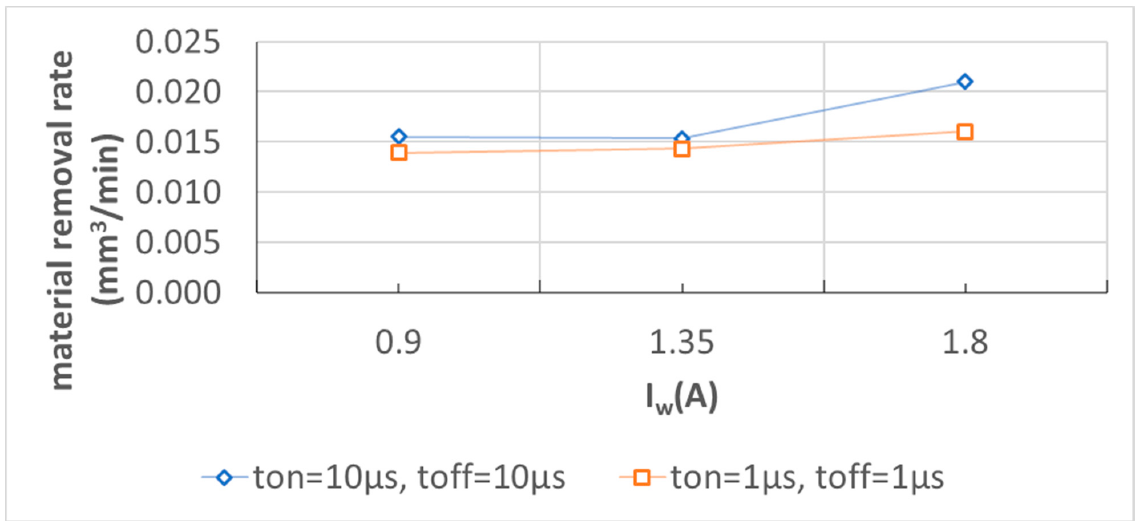
Figure 10. The material removal rate for various t on and t o ff and working current I w